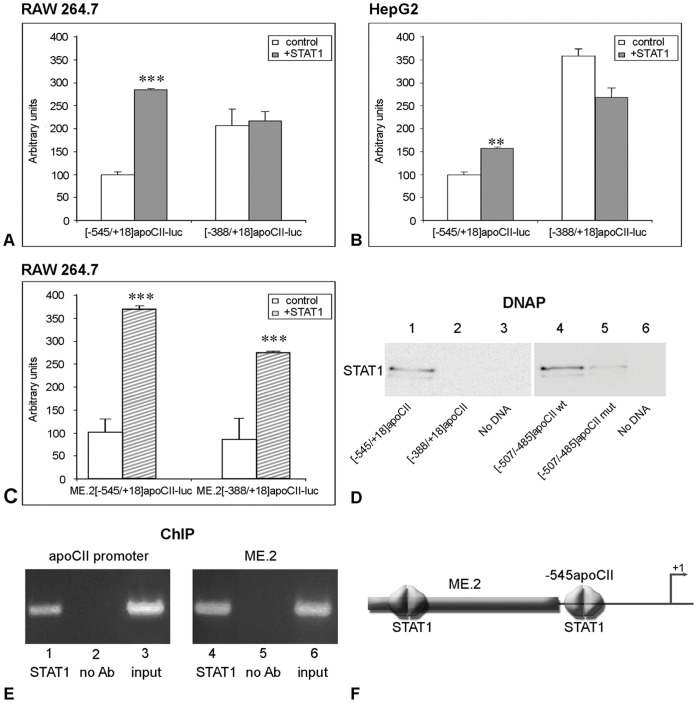
STAT1-dependent transactivation of apoCII promoter in RAW 264.7 cells.
Panel A, B. RAW 264.7 macrophages (A) and HepG2 hepatocytes (B) were transiently transfected with plasmids containing [−545/+18] or [−388/+18]apoCII promoter fragments in the presence or in the absence (control) of STAT1 expression vector. STAT1 overexpression increased the activity of [−545/+18]apoCII promoter in RAW 264.7 cells (∼3.4 fold, p<0.0001) as well as in HepG2 cells (∼1.5 fold, p<0.002). By contrast, the activity of the [−388/+18]apoCII promoter was not increased by STAT1 overexpression, either in macrophages (p>0.5) or in hepatocytes. Panel C. RAW 264.7 macrophages were transfected with ME.2[−545/+18]apoCII-luc or with ME.2[−388/+18]apoCII-luc plasmids in the absence (control) or in the presence of STAT1 expression vector. In the presence of ME.2, the activities of [−545/+18] and [−388/+18] promoter fragments were increased by STAT1 overexpression (3.8 fold, p<0.0002 and 2.9 fold, respectively p<0.0002). Panel D. DNA pull down assays were performed using different fragments ([−545/+18] and [−388/+18]) of apoCII promoter or oligonucleotides containing the wild type or mutated [−507/−485] region of apoCII promoter, and nuclear extracts obtained from STAT1- overexpressing HepG2 (right) and RAW 264.7 (left) cells. The results showed that the [−545/+18]apoCII promoter, but not [−388/+18] fragment can bind STAT1 proteins (lane 1 and, respectively 2). STAT1 is able to bind the wild type [−507/−485] region of apoCII promoter (lane 4), while STAT1 binding to the mutated region is impaired (lane 5). Negative controls, in which DNAP was performed without DNA, are illustrated in lanes 3 and 6 (no DNA). Panel E. ChIP experiments performed using anti-STAT1 antibodies showed that STAT1 is recruited to the [−738/−336]apoCII gene fragment as well as to the [140–440] ME.2 region (lanes 1 and, respectively, 4). No bands were obtained when anti-STAT1 antibodies were omitted in ChIP experiments for apoCII promoter and for ME.2 region (lanes 2 and, respectively, 5). PCR using the input as template and primers for apoCII promoter or ME.2 gave the expected bands (lanes 3 and, respectively, 6). Panel F. Schematic representation of STAT1 binding sites on apoCII proximal promoter and ME.2 region.